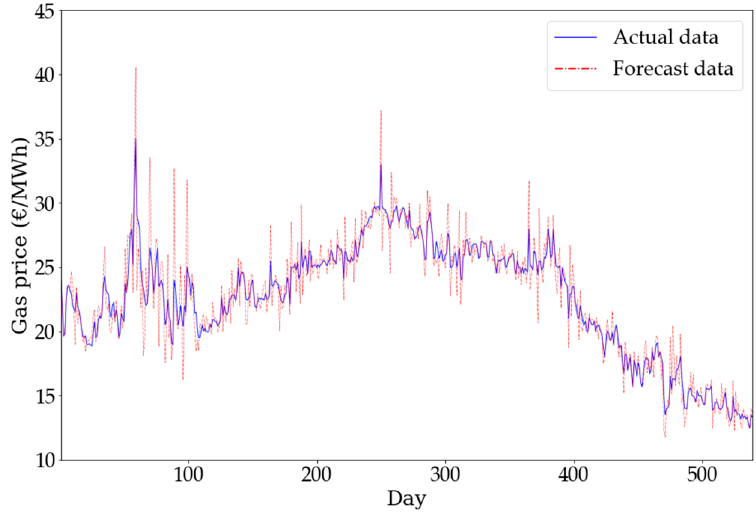
Figure 9. Fit the entire historical data set of gas price with a relative error equal to 3.93%.